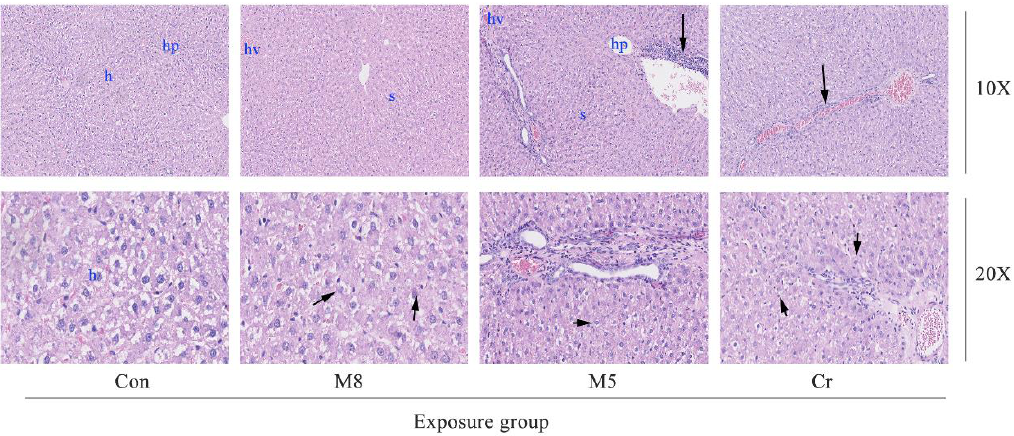
Figure 4. Photomicrographs of liver histopathology. The images (magnification 10 × , 20 × ) represent the histopathological sections of the liver. Dark arrows in the M8 group (20 × ) represent granular degeneration; in the M5 group (10X) represent the small focal-like inflammatory cells infiltration around the portal area; in the M5 group (20X) represent lymphocyte aggregation; in the Cr group (10 × ) represent small focal-like inflammatory cells infiltration around the hepatic vein; in the Cr group (20 × ) represent hepatocyte granule degeneration and small stove liver cell shrinkage. Abbreviations: Con, control group; M8: the mixture of eight common metals (Pb + Cd + Hg + Cu + Zn + Mn + Cr + Ni); M5: the mixture of five non-essential metals (Pb + Hg + Cd + Ni + Cr); Cr, chromium; h, liver hepatocytes; hp, hepatic portal; s, sinus; hv, hepatic vein.